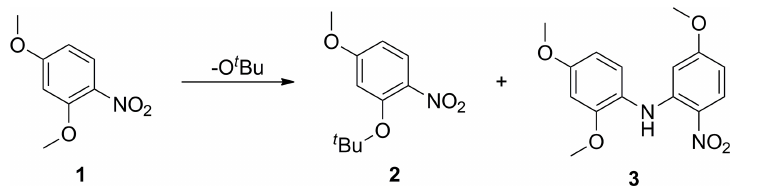
Fig 2. S N Ar reaction of 2,4-dimethoxynitrobenzene with tert